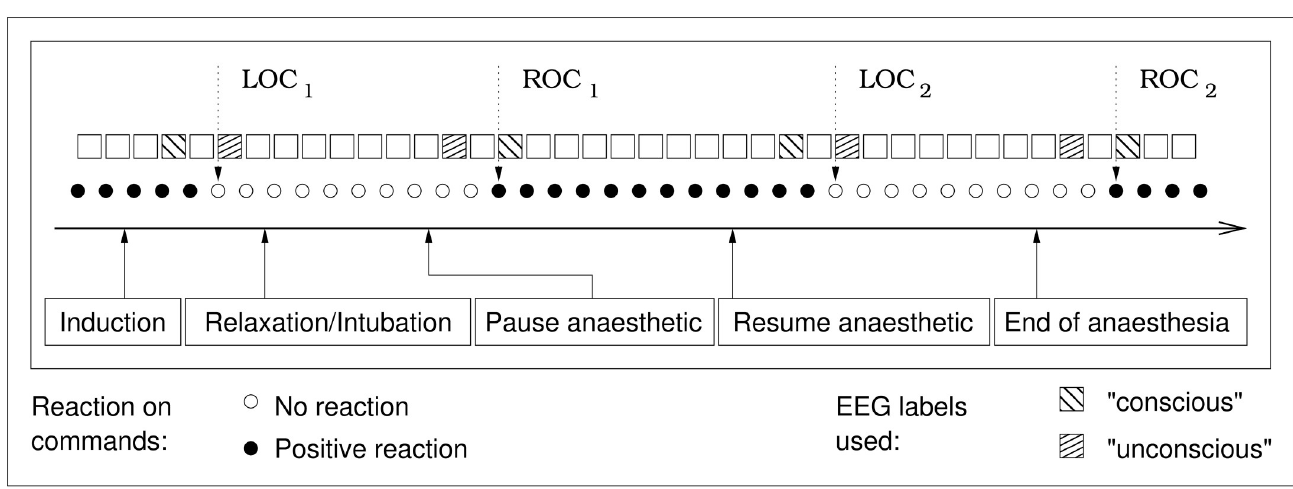
Fig 1. Schematic overview of the study protocol. LOC: Loss of consciousness; ROC: Return of consciousness. Time frame duration: 10s for EEG parameters, variable for AEP parameters. Duration between two requests to push the hand: 30s. The actual surgery period is not depicted in this figure, it took place between LOC 2 and ROC 2